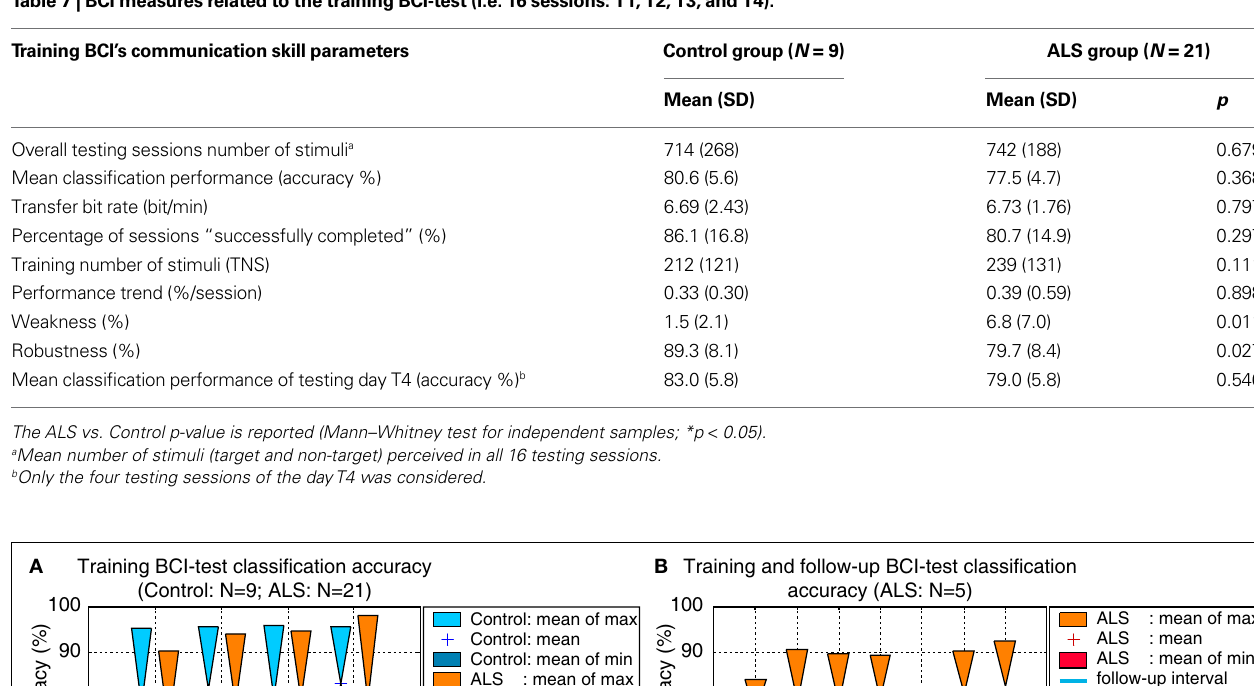
lowing fi ve measures (all 16 TS were considered, see Table 7 and Figure 4A ): mean classifi cation performance (i.e. target and non-tar- get single-sweep classifi cation accuracy%), transfer bit rate (bit/min, according to Piccione et al., 2006), percentage of “successfully com- pleted” sessions (%), TNS, and the classifi cation performance trend for the 16 TS of the training BCI-protocol (%/session), evaluated with a linear regression. Two further measures was used to monitor the effect of on-line artefacts on participants’ performance (epochs with an EEG activity larger than 100 µV were considered as an artefact, Cohen and Polich, 1997): BCI-system weakness as the percentage of target epochs classifi ed as true positive (TP) and containing an artefact with respect to all target epochs; BCI- system robustness as the percentage of non-target epochs classifi ed as true negative (TN) and containing an artefact, with respect to all non-target epochs with artefacts. Weakness measure refers to the infl uence of on-line artefacts on correct movements of the cursor; robustness measure refers to the capability of the algorithm to reduce/avoid wrong movements of the